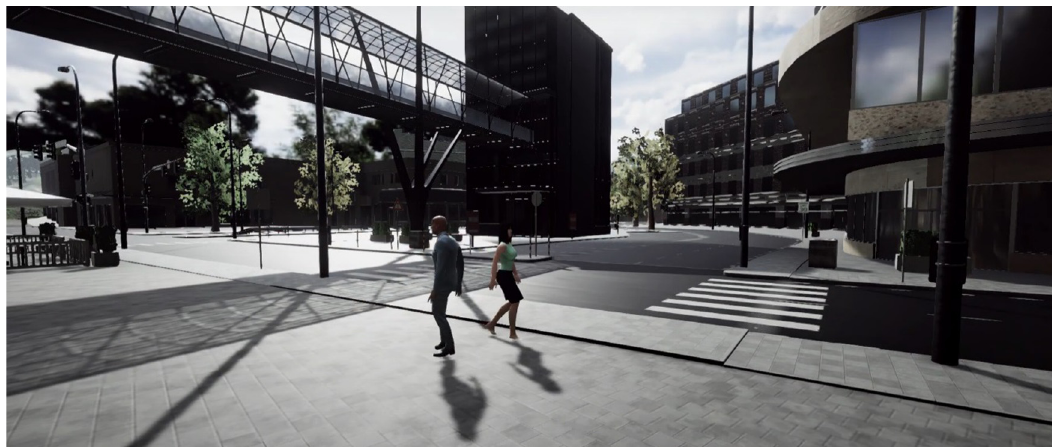
Figure 8: A screenshot from the implementation application.